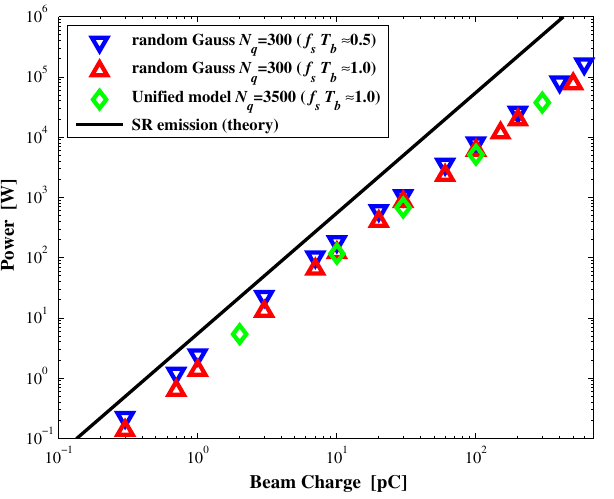
FIG. 6. Radiation power of a prebunched FEL as a function of the number of beam microbunches (relative beam duration f T m b ). The modulation index and the modulation frequency are m ¼ 50% and f m ¼ 3 THz,